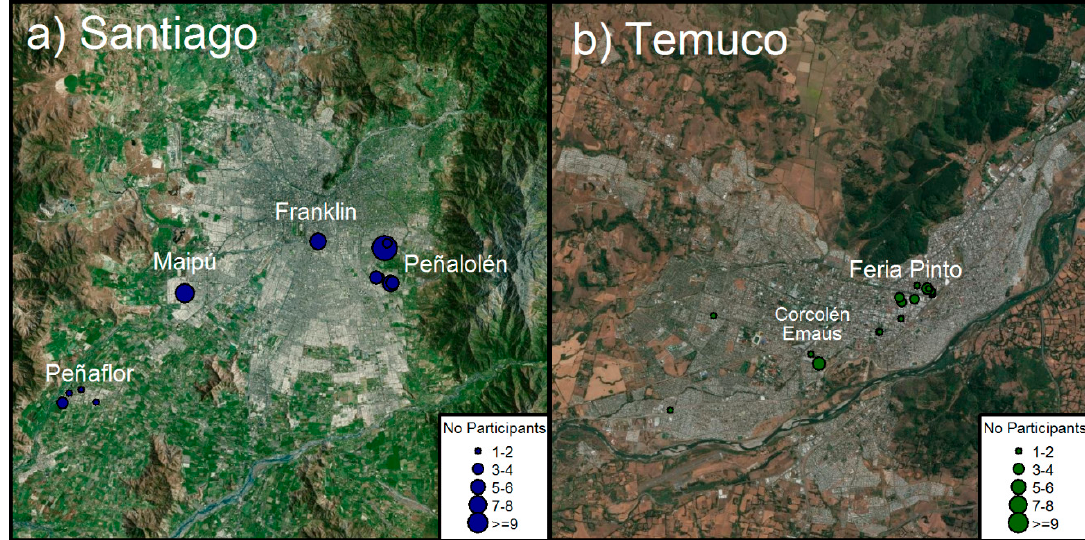
Figure 1. Study site: ( a ) map of Santiago; ( b ) map of Temuco 118